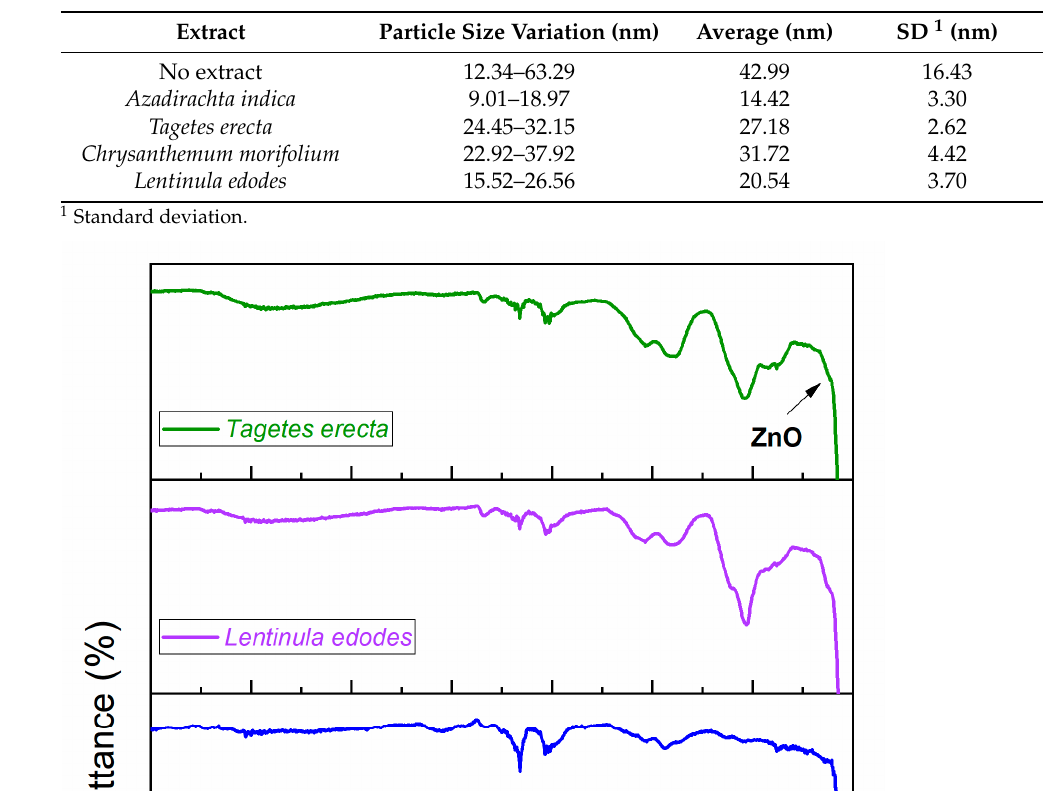
Table 1. Size variation of the ZnO NPs.